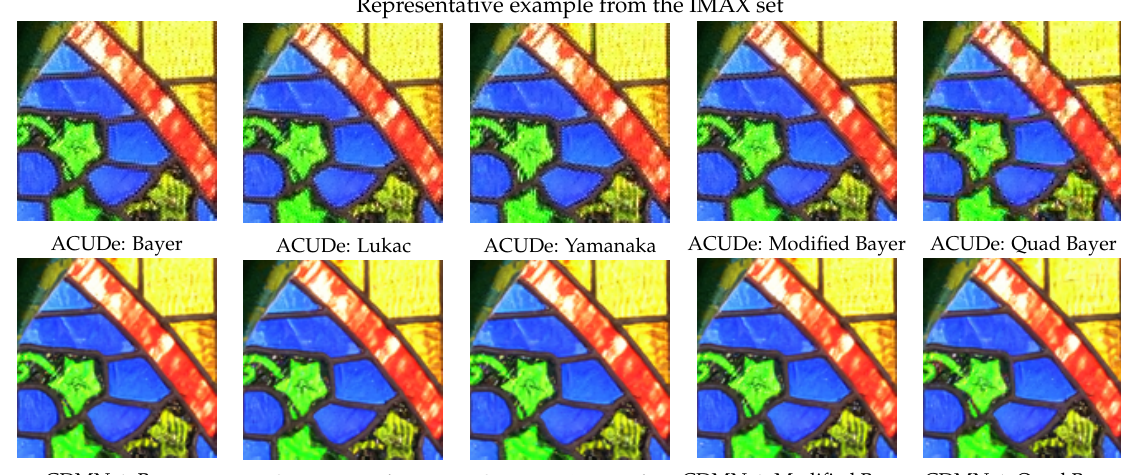
Figure 11. Results obtained for the representative examples from KODAK and IMAX data-sets. Two algorithms were analysed: (1) the modified ACUDe based on the algorithm presented in [28], as a state-of-the-art generic algorithm among the classical demosaicing techniques and (2) the modified CDMNet based on the algorithm presented in [25] as a state-of-the-art generic algorithm among the learning-based demosaicing techniques. The algorithms were tested on five Bayer-like CFA patterns. There are no big visual differences between the reconstructed images from different CFA inputs when the modified CDMNet (the representative of the modern learning-based demosaicing techniques) is